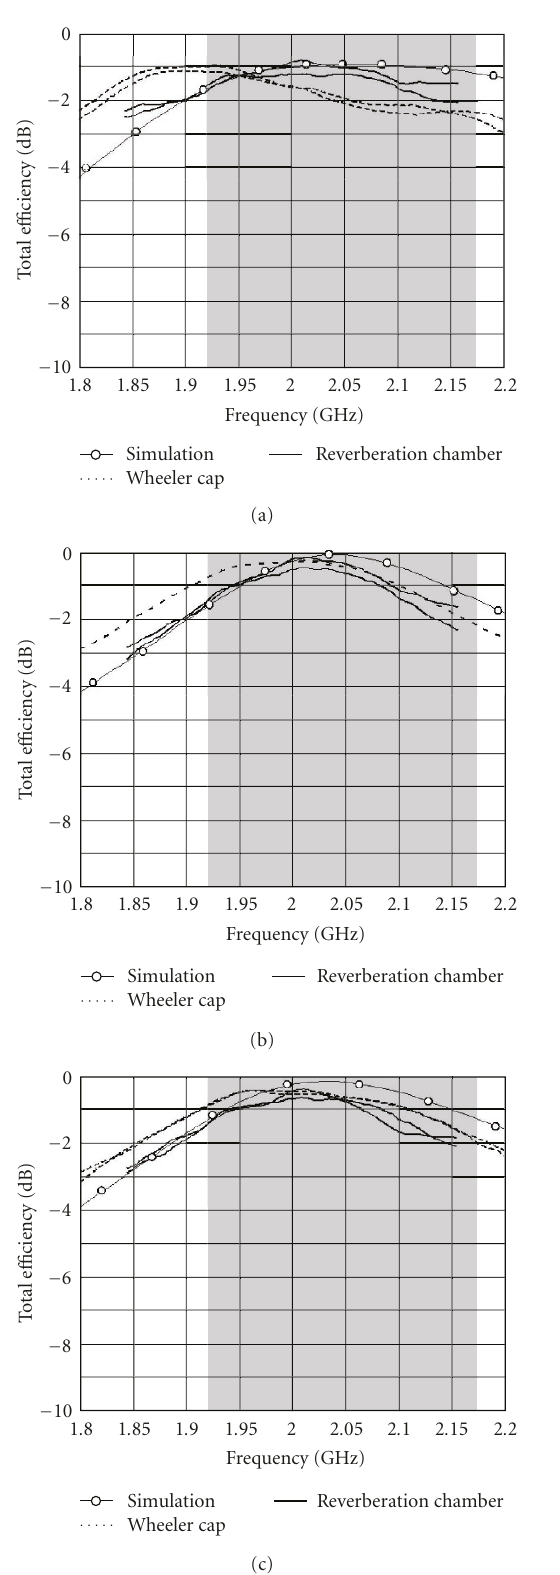
Figure 7: Total e ffi ciency of the two-antenna structures: (a) with- out the neutralization line, (b) with the neutralization line between the feeding strips, and (c) with the neutralization line between the shorting strips.